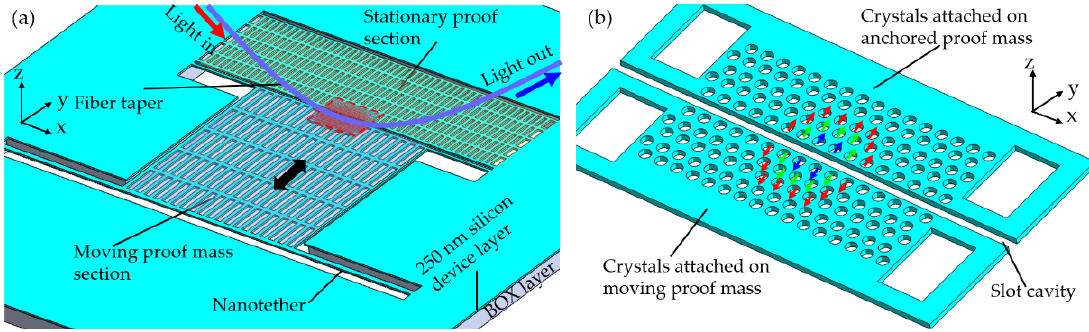
Figure 25. ( a ) Schematic of a chip-scale 2D PhC slot cavity for acceleration sensing; ( b ) close-up view of optomechanical cavity with colored arrows denoting three different photonic crystal lattice perturbations resulting in optomechanical stiffening [144,145] .